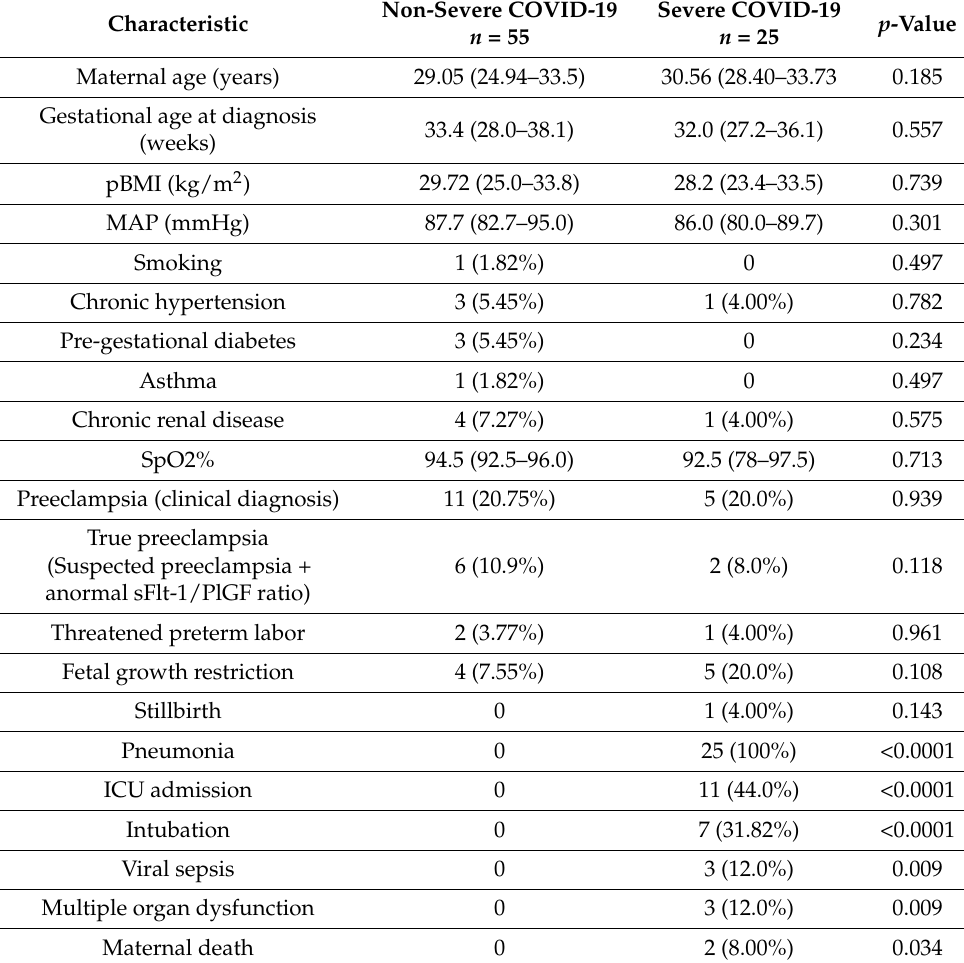
Table 1. Clinical characteristics of the study